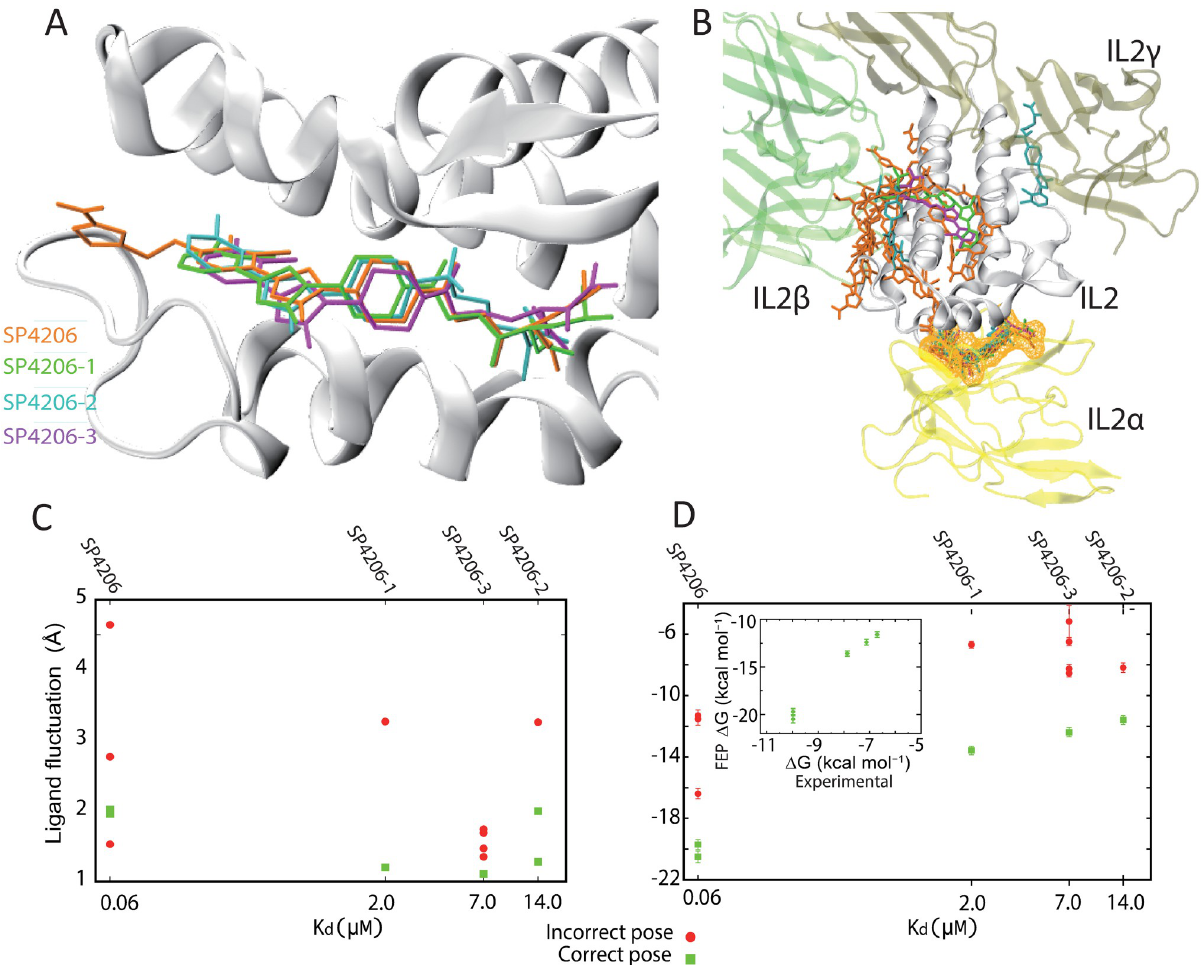
Fig 2. Simulations of binding of SP4206 analog molecules and free energy calculation. (A) The binding poses of SP4206 and its analogs generated by spontaneous binding simulations. (B) The non-native binding poses of SP4206 and its analogs generated by simulations, shown in the structural context of IL2-IL2R association. The native binding pose is also shown with a mesh around the small molecule. The colors of the small molecules are as shown in (A). (C) The conformational fluctuations of SP4206 and analogs in simulation-generated binding poses ( y -axis) compared to the dissociation constants of the compounds ( x -axis). As shown, with one exception for SP4206, the fluctuation is smaller in the native binding pose than in the non- native ones for the same compound. (D) The FEP binding free energies of SP4206 and analogs in various simulation-generated binding poses ( y -axis) compared to the dissociation constants (K d ) of the compounds ( x -axis). The binding free energy was estimated to be 20.5 ± 0.38 or 19.7 ± 0.33 kcal mol − 1 for SP4206, 13.58 ± 0.28 kcal mol − 1 for SP4206-1, 11.59 ± 0.29 or 11.58 ± 0.28 kcal mol − 1 for SP4206-2, and 12.39 ± 0.3 kcal mol − 1 for SP4206-3. In the inset, the calculated binding energy ( y -axis) is compared to the binding energies derived from K d ( x -axis). For a given compound, the calculated binding energy is consistently greater for the native binding pose than for the non-native